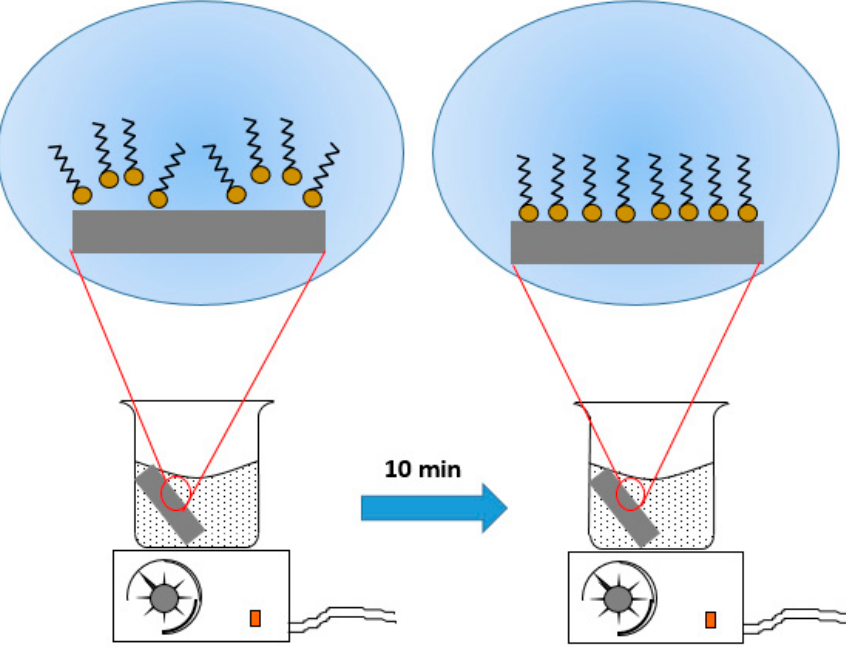
Figure 6. Illustration of octadecyltrimethoxysilane (S18) molecules, with wavy lines representing the hydrocarbon chain and yellow circles representing the head groups dissolved in toluene.